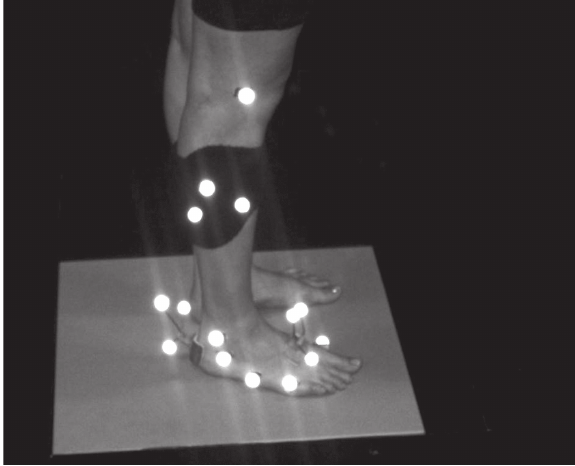
Figura 2 - Coleta dinâmica com o indivíduo calçado Fonte: Dados da